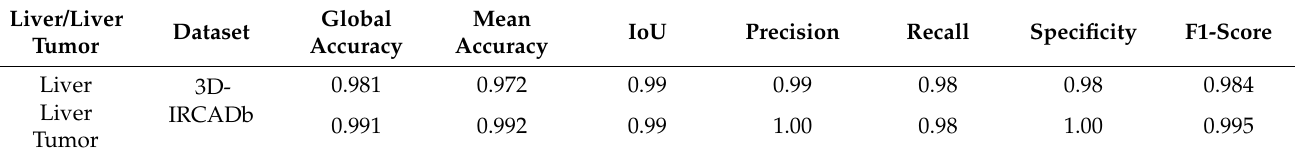
Table 7. Liver segmentation using CT images.